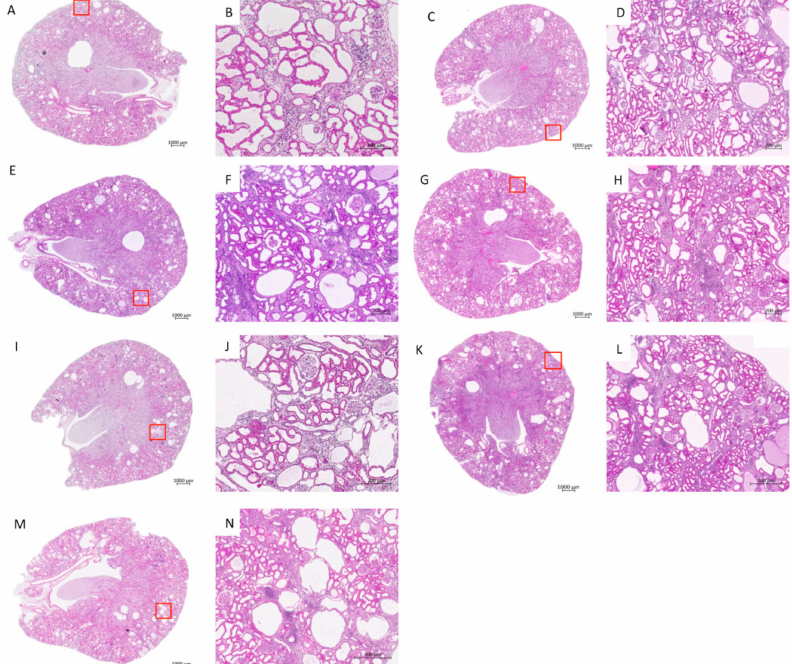
Figure 3. Haematoxylin and eosin (H&E) staining of PKD/Mhm (Cy/+) rat kidneys. Altered renal morphology in ( A ) PKD/Mhm (Cy/+) rat and ( B ) corresponding magnification of cyst details (red square); ( C ) ABCB5 + -derived CoCM + treated rat and ( D ) corresponding magnification of cyst details; ( E ) ASC-derived CM-treated rat and ( F ) corresponding magnification of cyst details; ( G ) i.p. ABCB5 + -treated rat and ( H ) corresponding magnification of cyst details; ( I ) i.p. ASC-treated rat and ( J ) corresponding magnification of cyst details; ( K ) i.v. ABCB5 + -treated rat and ( L ) corresponding magnification of cyst details; ( M ) i.v. ASC-treated rat and ( N ) corresponding magnification of cyst details. Images acquired with Axio Scan.Z1 microscope (ZEISS), 20 × objective; ( B , D , F , H , J , L , N ) are zoomed in images of the area used to check the size of the scale